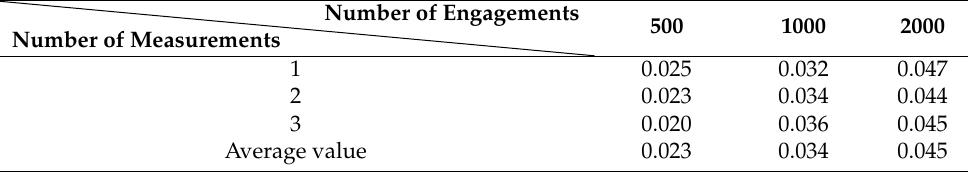
Table 5. Measurement result of friction disk wear with two-way parallel groove (unit: mm). Number of